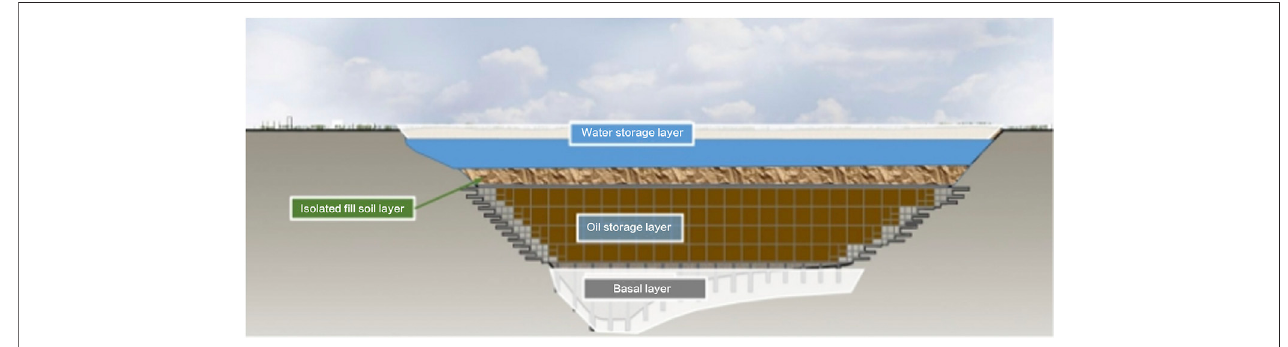
FIGURE 3 | The single-pit oil – water co-storage